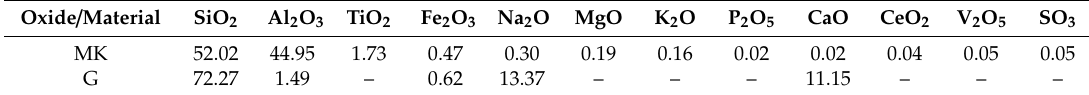
Table 2. Chemical composition of metakaolin (MK) and glass waste (wt.%).